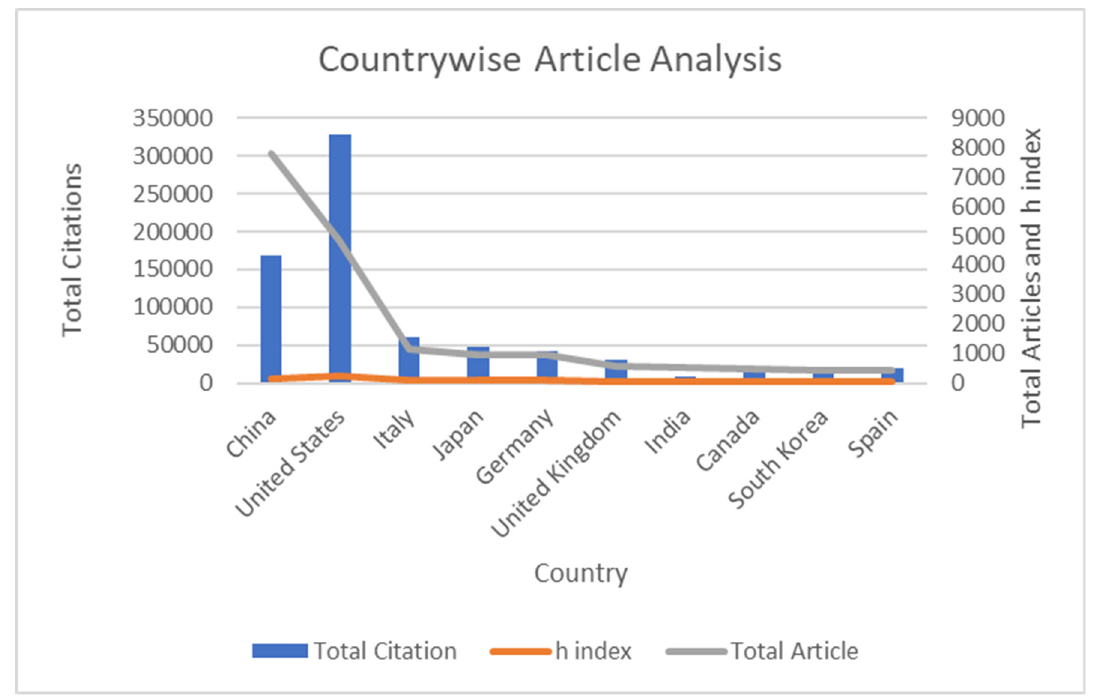
Figure 3. Country-wise article analysis. Table 4. Top 10 productive countries in miRNA in cancer article publication.